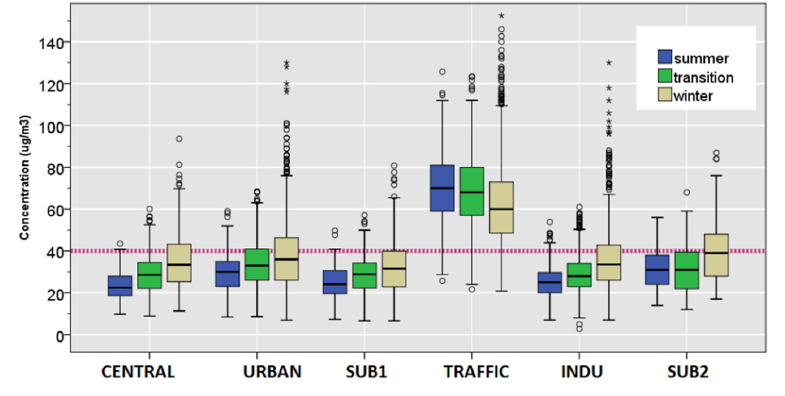
Figure 6. Distributions of daily NO 2 concentration (µg/m 3 ) by season. The dotted line shows the EU annual mean standard of 40 µg/m 3 .